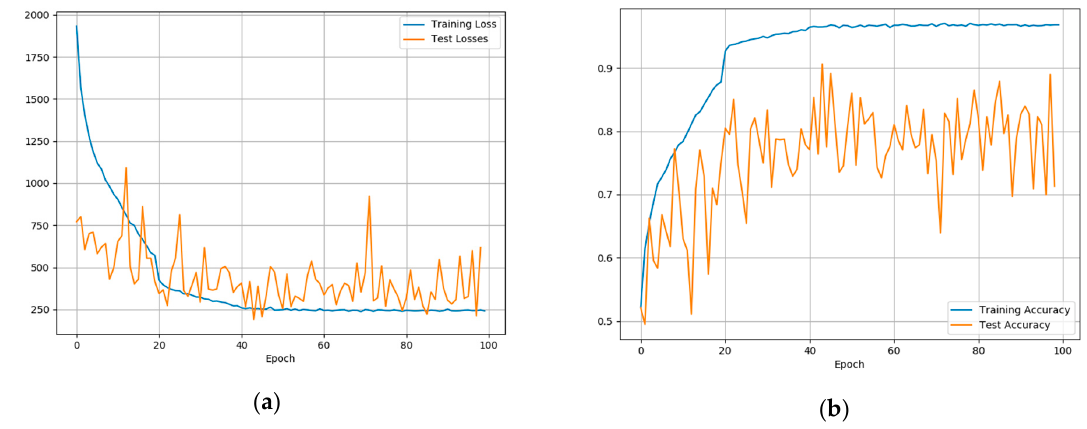
Figure 12. Training and test losses and accuracy: ( a ) training and test losses; ( b ) training and test accuracy.